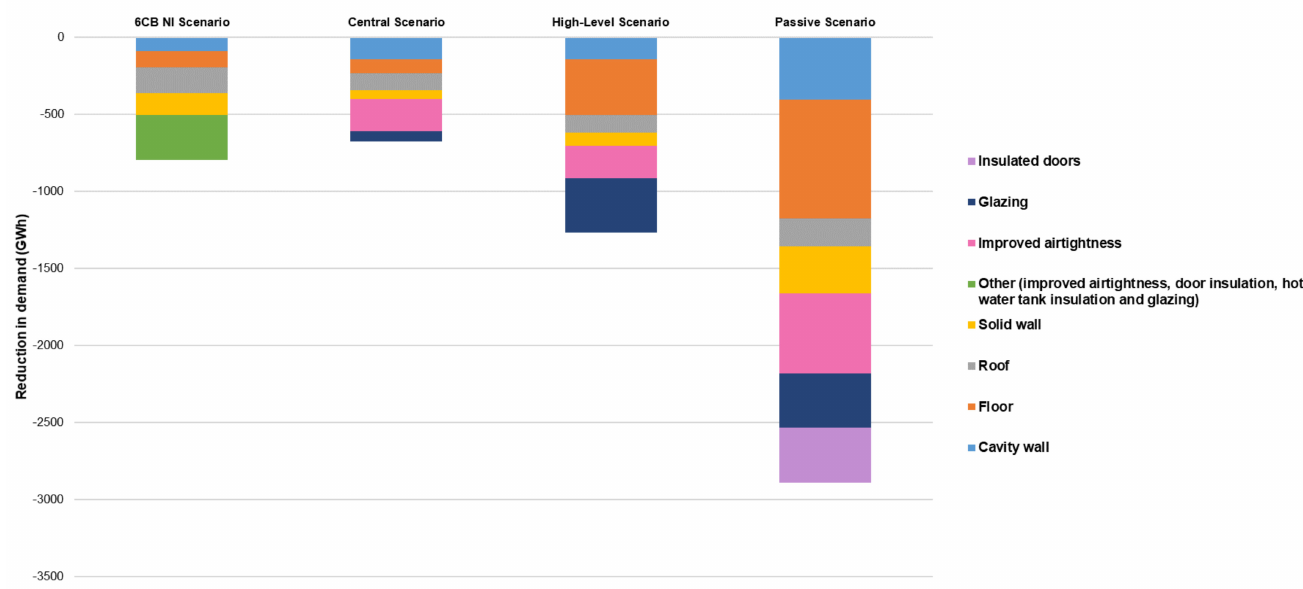
Figure 6. Reductions in heat demand per measure across all scenarios compared with those of the 6CB NI Central